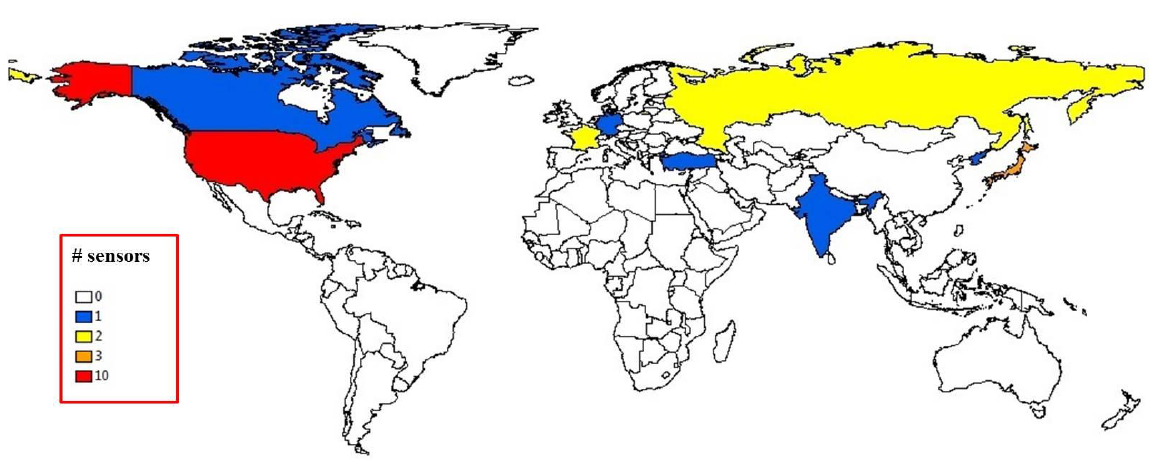
Figure 2. Developer countries of investigated sensors.